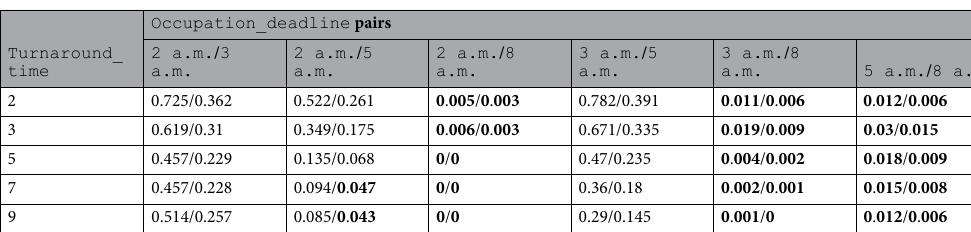
Table 2. GB 2 colony in 2008 with lf_delay = 5 min. Wilcox rank-sum test was performed with 10 3 bootstraps. Table cells are formatted as p 1 / p 2 , where p 1 and p 2 are the p-values for the hypotheses H 1 and H 2 , respectively. Bold values indicate that the corresponding null hypotheses (see main text) can be rejected in favor of the alternatives ones at a statistically significant level.